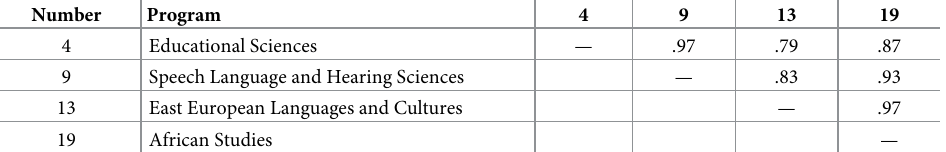
Table 3. Comparison (correlations) RIASEC profiles of educational sciences , speech language and hearing sciences , East European Languages and Cultures and African Studies .